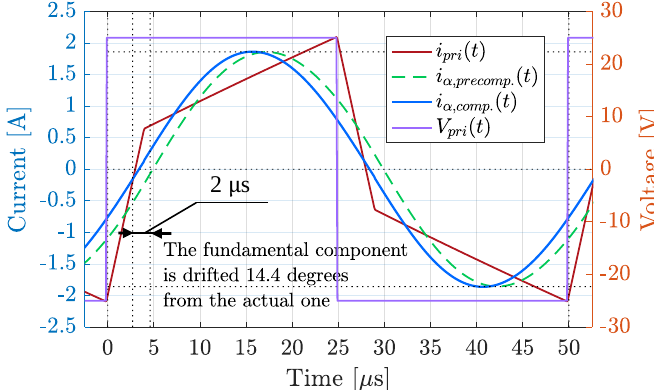
Figure 4. Phase drift effect when terminal voltages are not